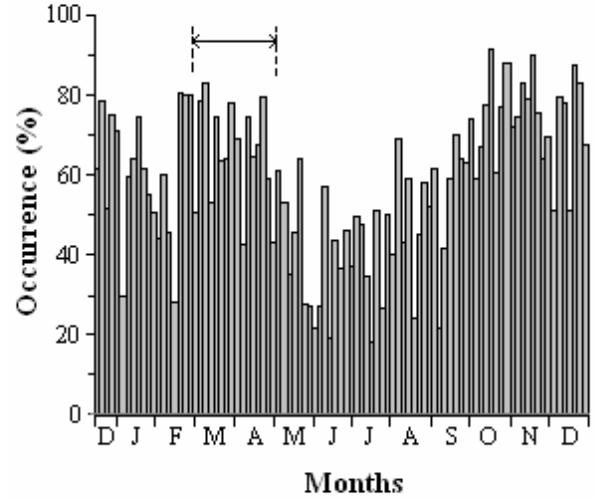
Table 1. Daily Magnetic index Am for the period 1 March–30 April.